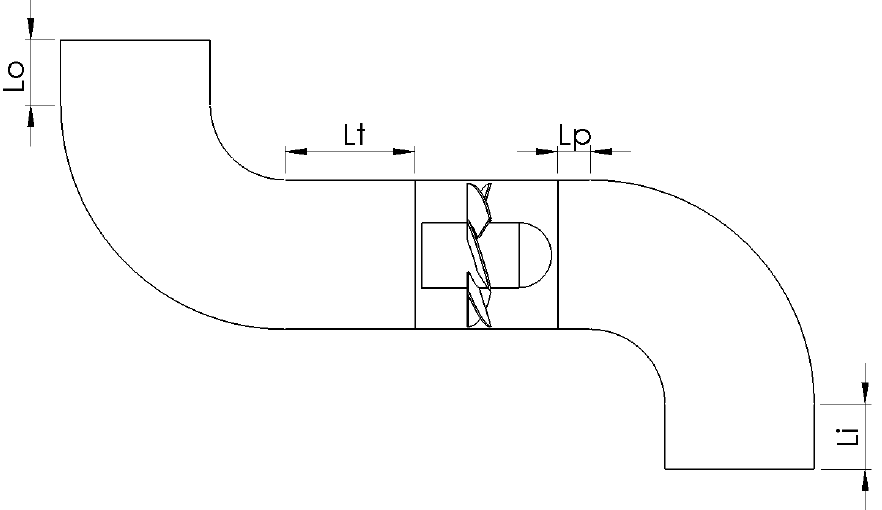
Figure 2. Diagram of built-in fan.